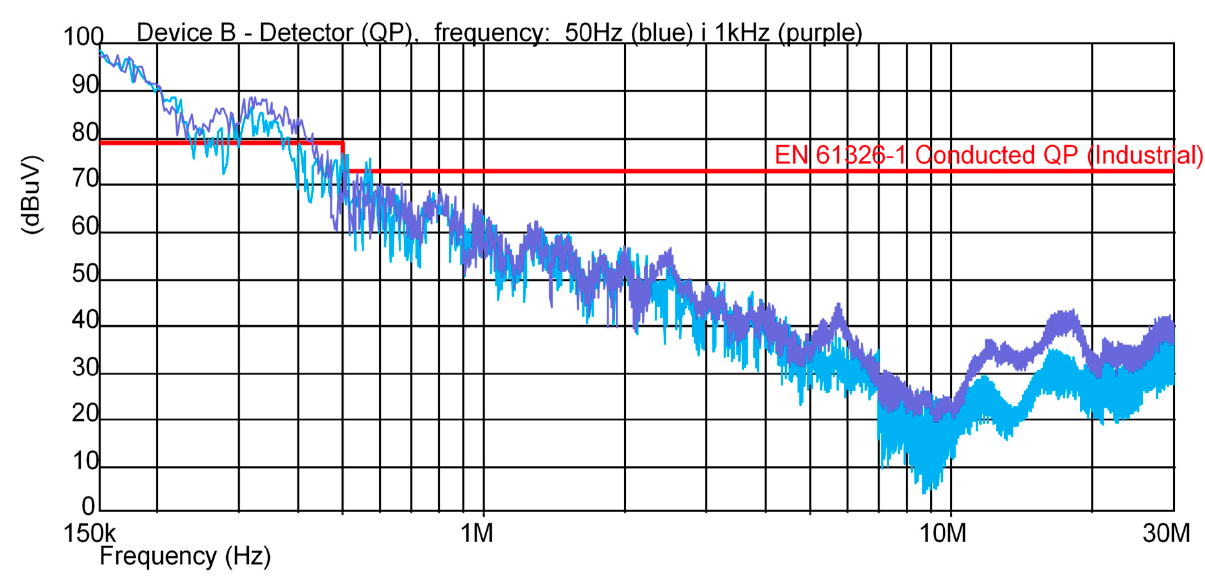
Figure 4. Frequency spectrum of conducted emission of the audio power amplifier (device B) for frequencies of generated voltage by the device under test equal to 50 and 1000 Hz.